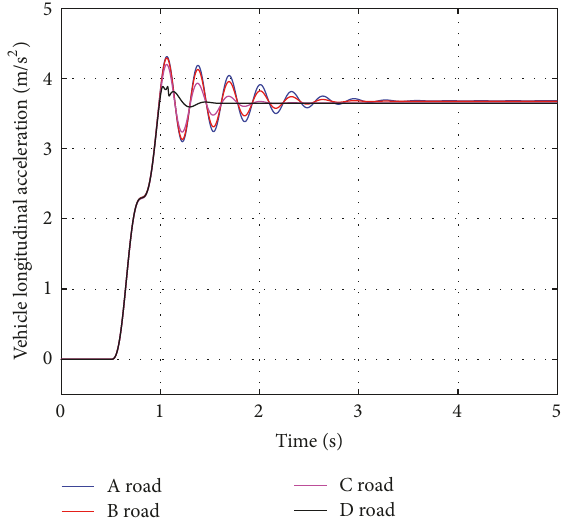
Figure 12: Slip ratio-friction coefficient curve in the four road conditions. Table1:MagicTireFormulaparametersinthefourroadconditions. Road conditions